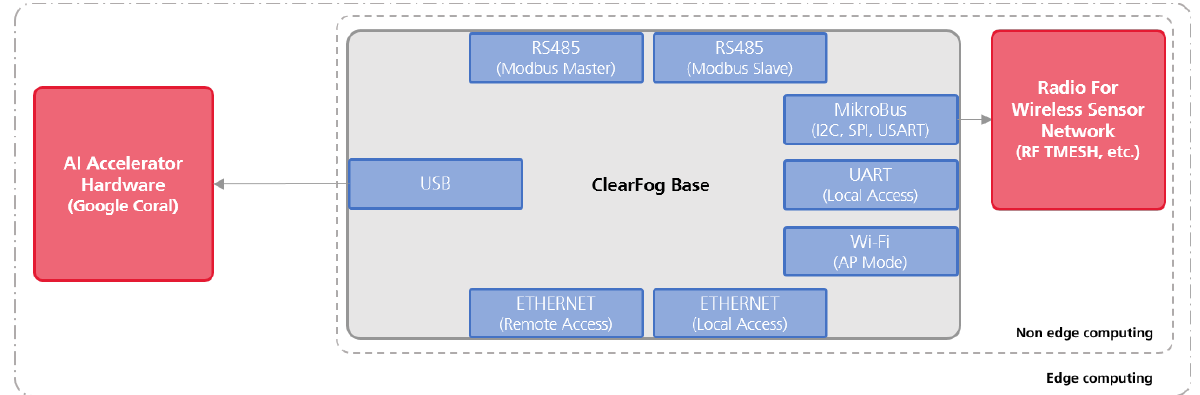
Figure 2. TIP4.0 hardware